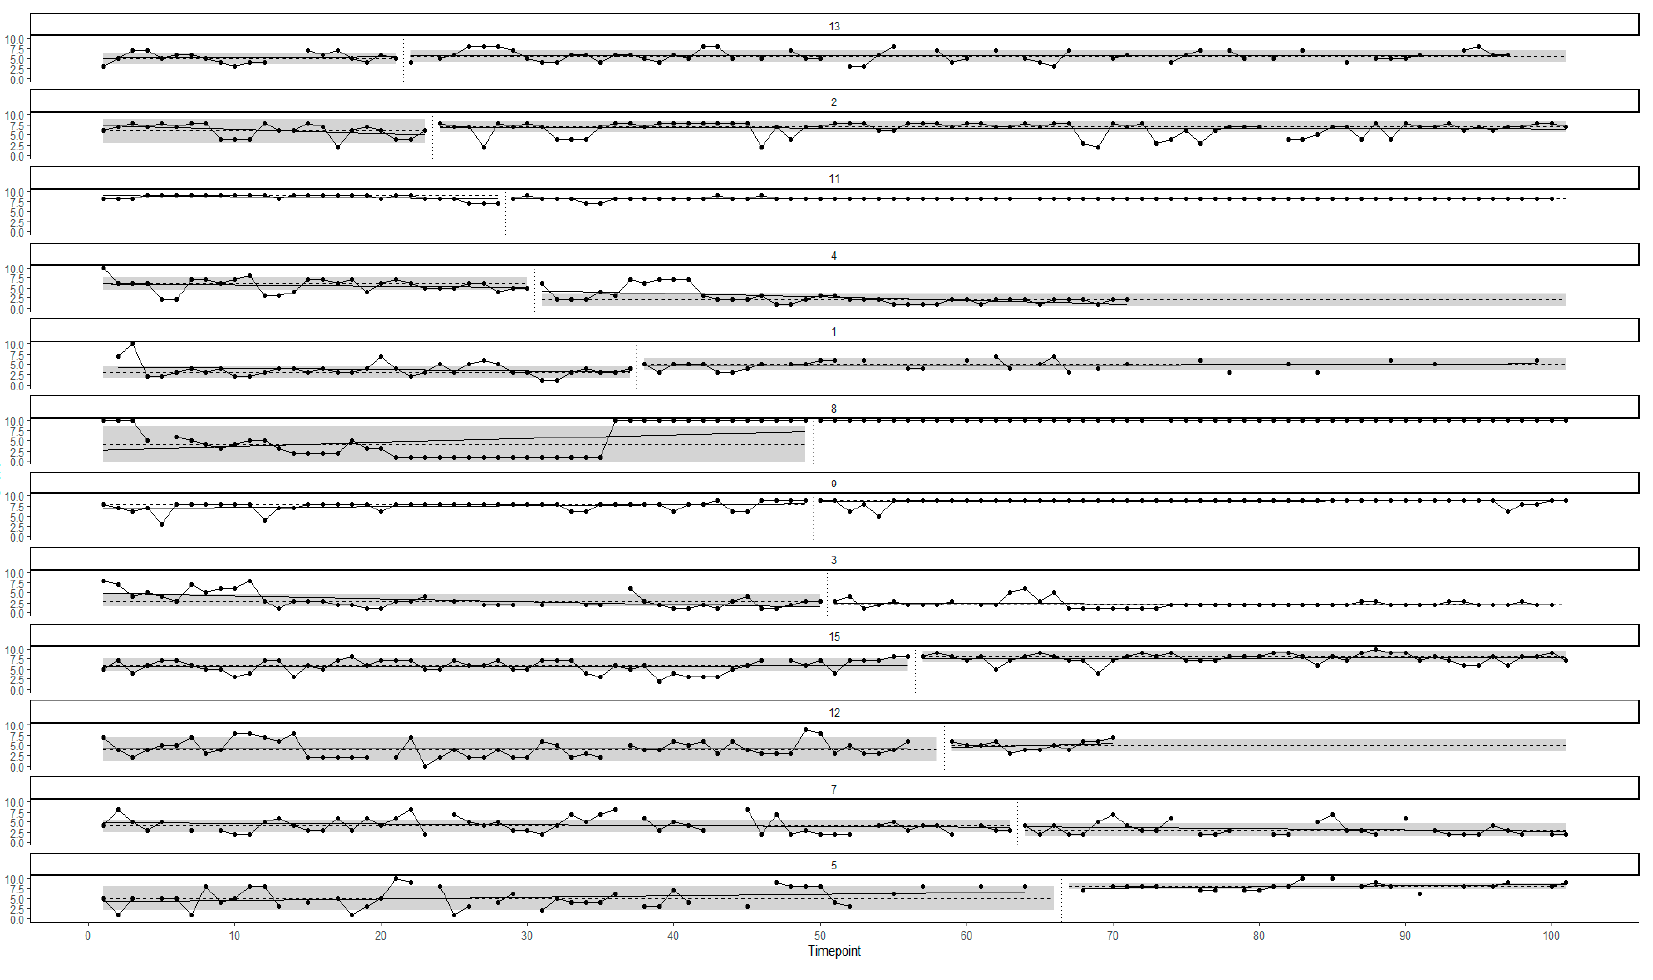
Figure A4. SCED data for all study 2 participants on daily measure of openness to experience. Note: Participant data are ordered via the order in which they received the intervention. Vertical dotted lines denote the data point at which the intervention was delivered. Shading denotes the one median absolute deviation from the median. Dashed horizontal lines denote the median while solid lines denote within-phase OLS regression trend lines.